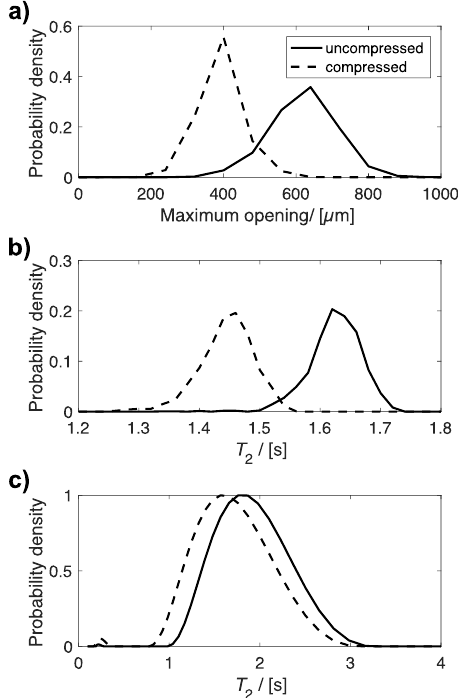
Figure 5. Plots of the distribution of ( a ) maximum opening, ( b ) T 2 relaxation time determined from T 2 relaxation MR maps, and ( c ) bulk T 2 relaxation time for the same uncompressed and compressed plug.